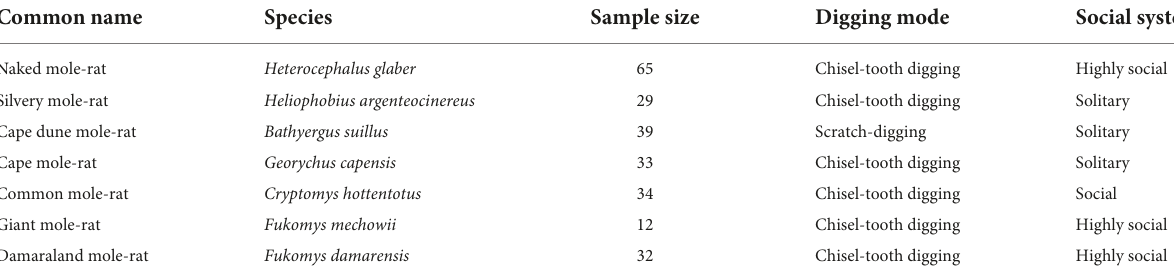
TABLE 1 Main characteristics of the seven bathyergid species analyzed in this